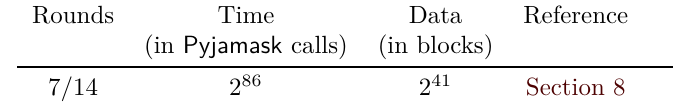
Table 2: Overview of the results on our key recovery attacks on Pyjamask